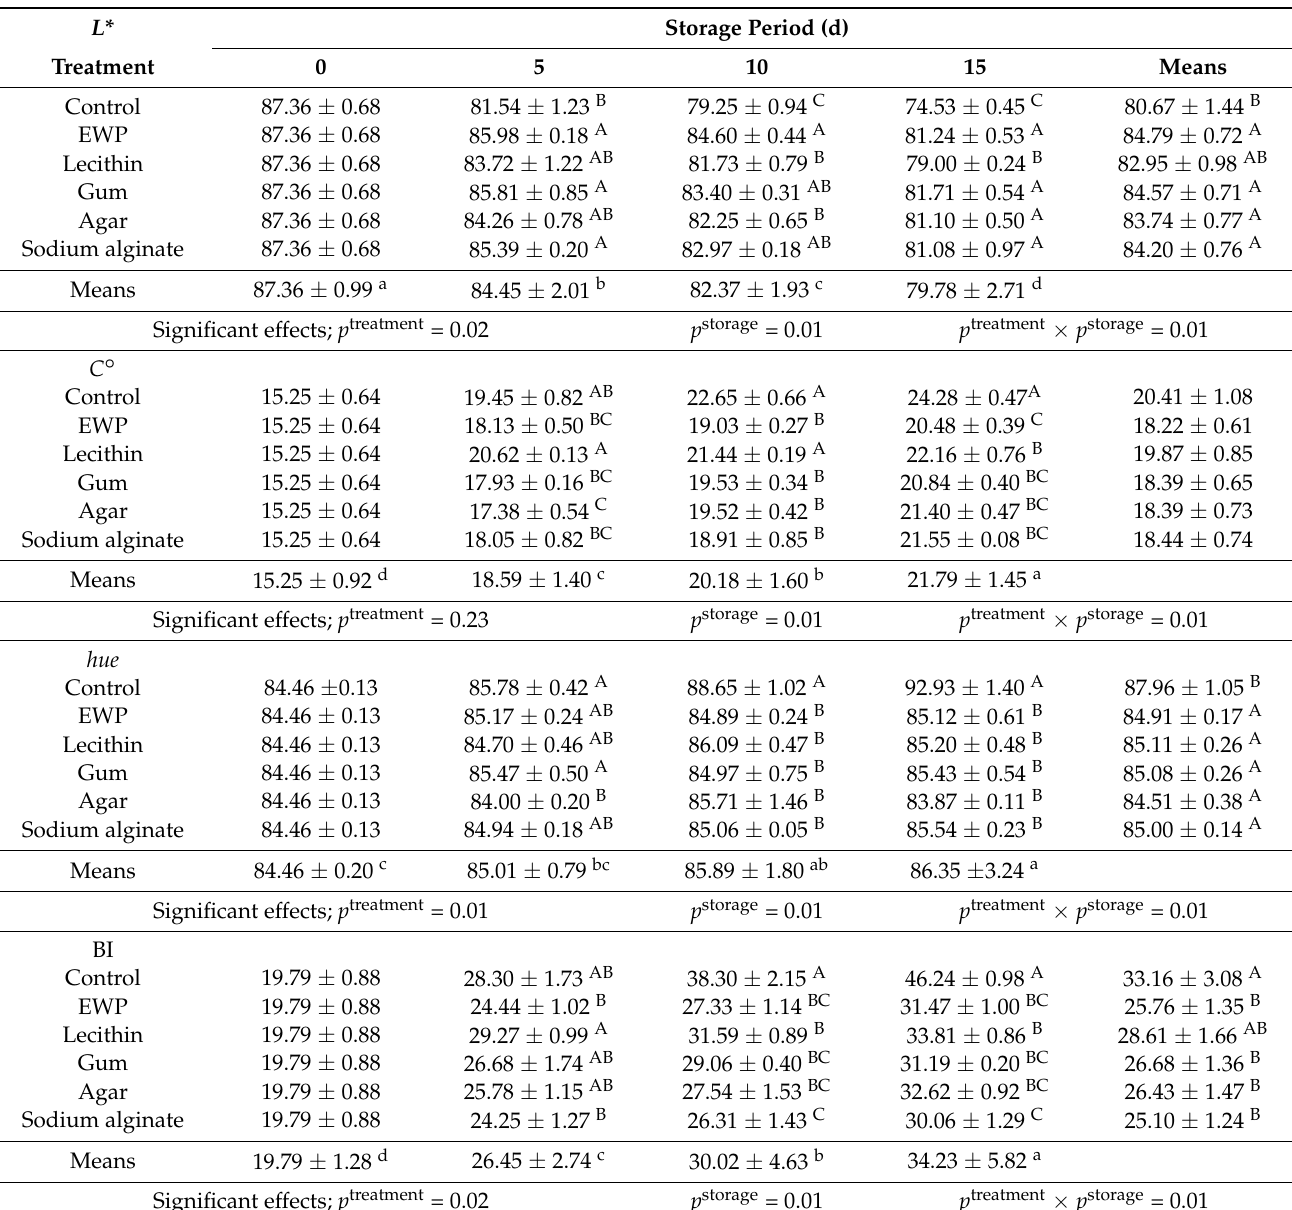
Table 2. The changes in L* , C ◦ , hue, and browning index (BI) during the storage of button mushrooms over 15 d at 4 ◦ C. Data are presented as means ±